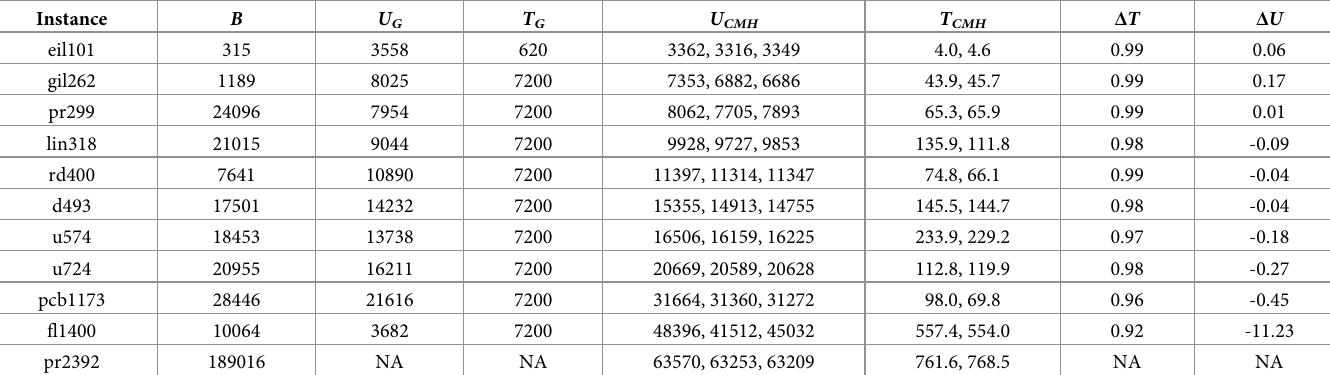
Table 4. Performance of Gurobi as standalone algorithm and when used in the clustering metaheuristic ( Random instances). Instance